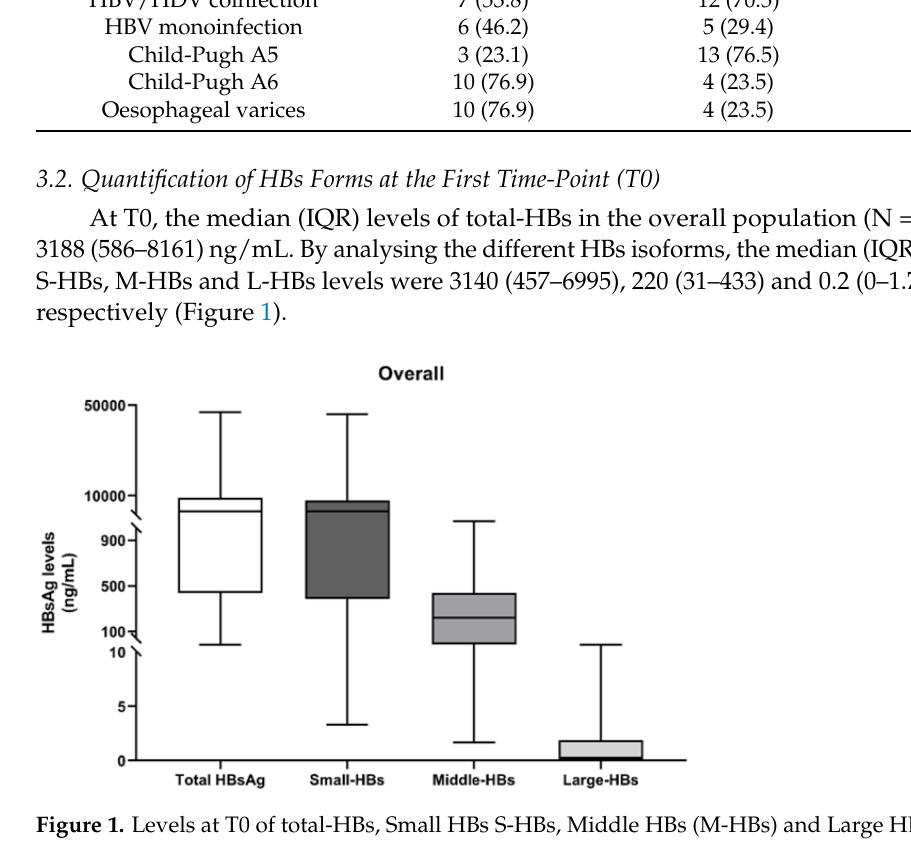
Figure 1. Levels at T0 of total-HBs, Small HBs S-HBs, Middle HBs (M-HBs) and Large HBs (L-